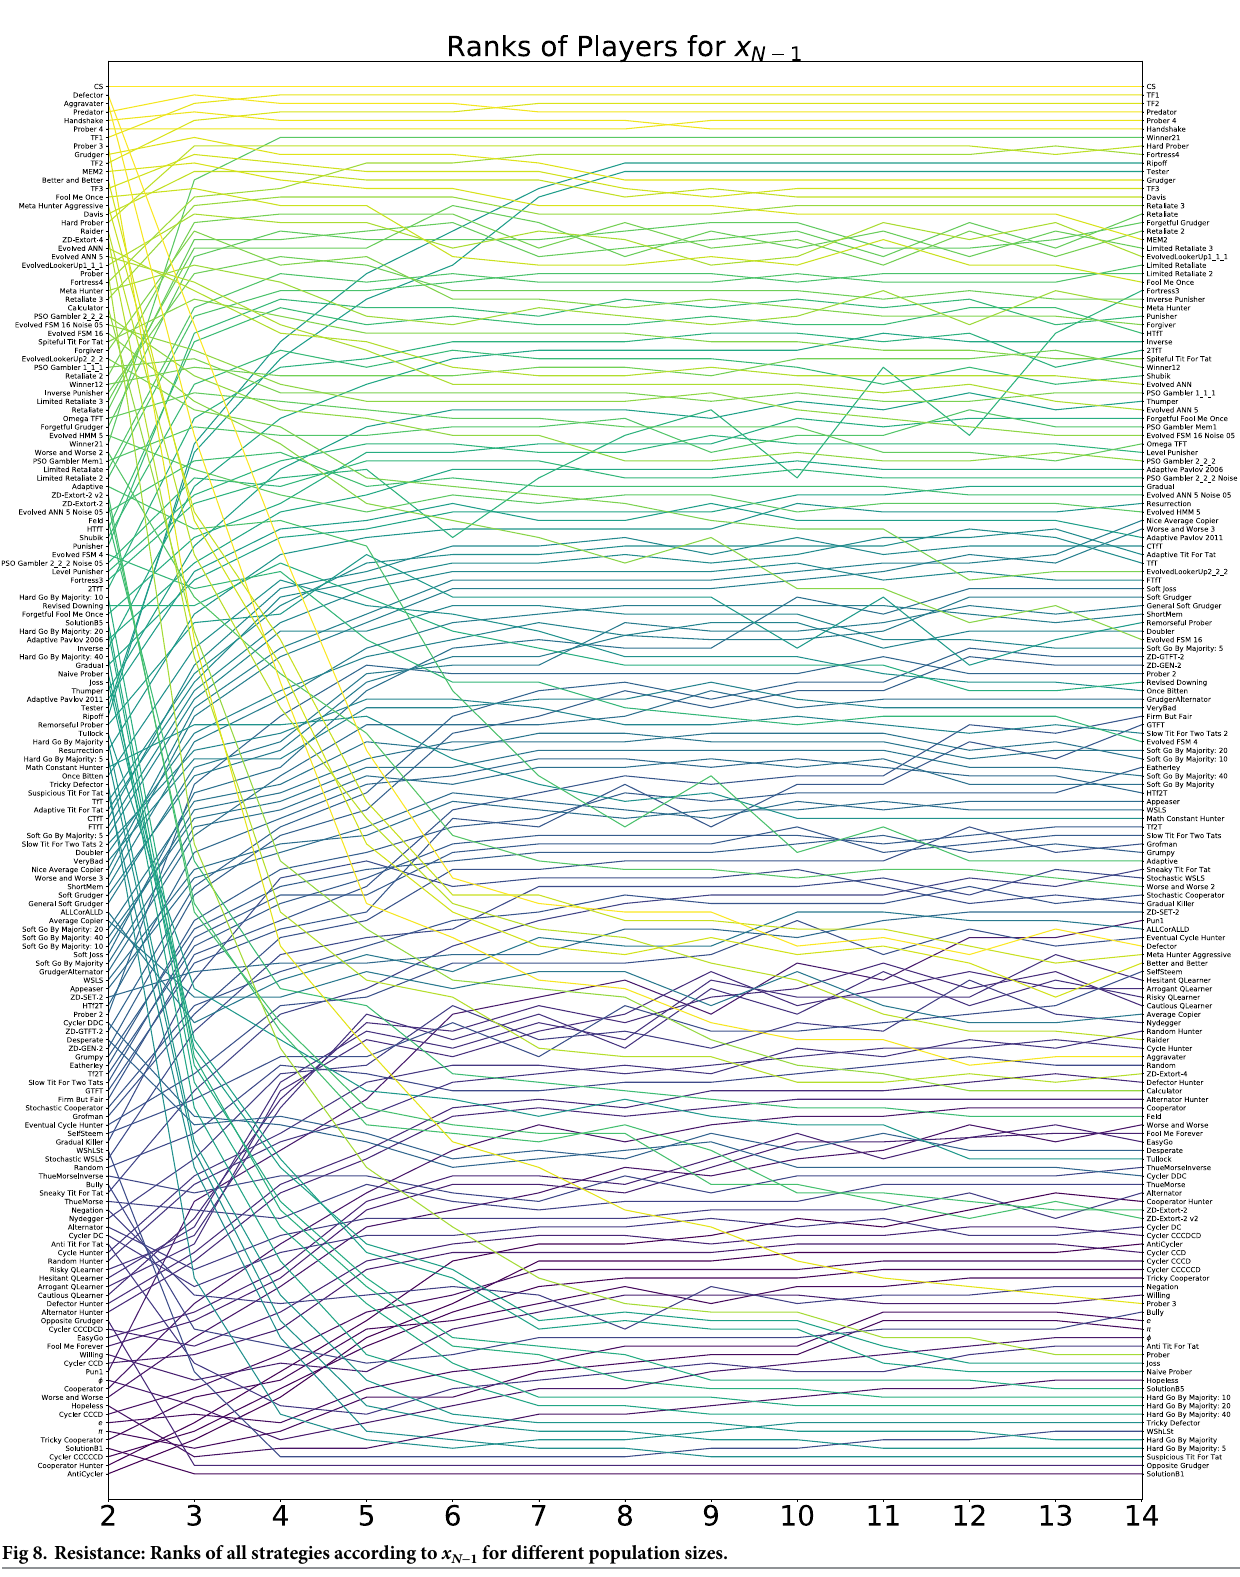
Fig 8. Resistance: Ranks of all strategies according to x N − 1 for different population sizes.